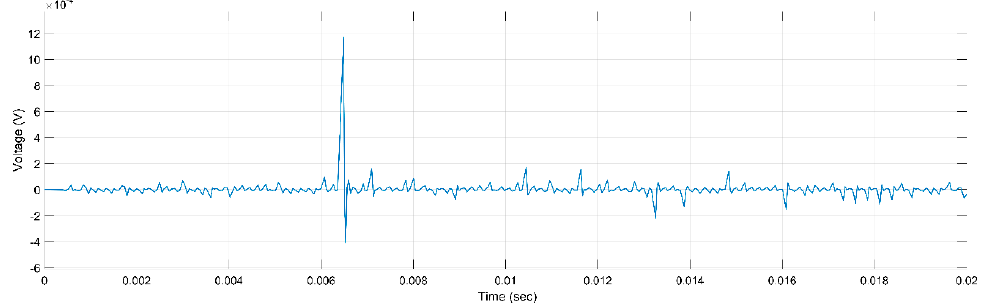
Figure 7. PD Activity for Mica, 10 kV, h, r.